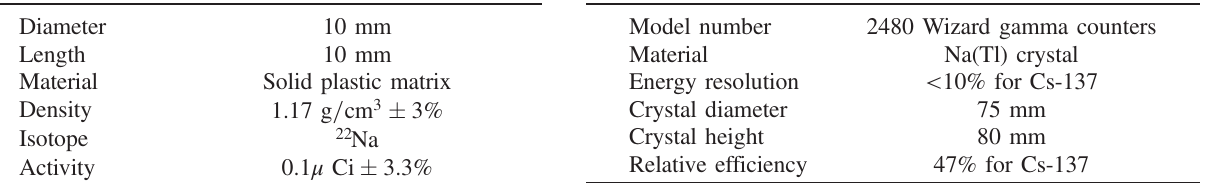
TABLE IV. Specifications of the well-type detector at